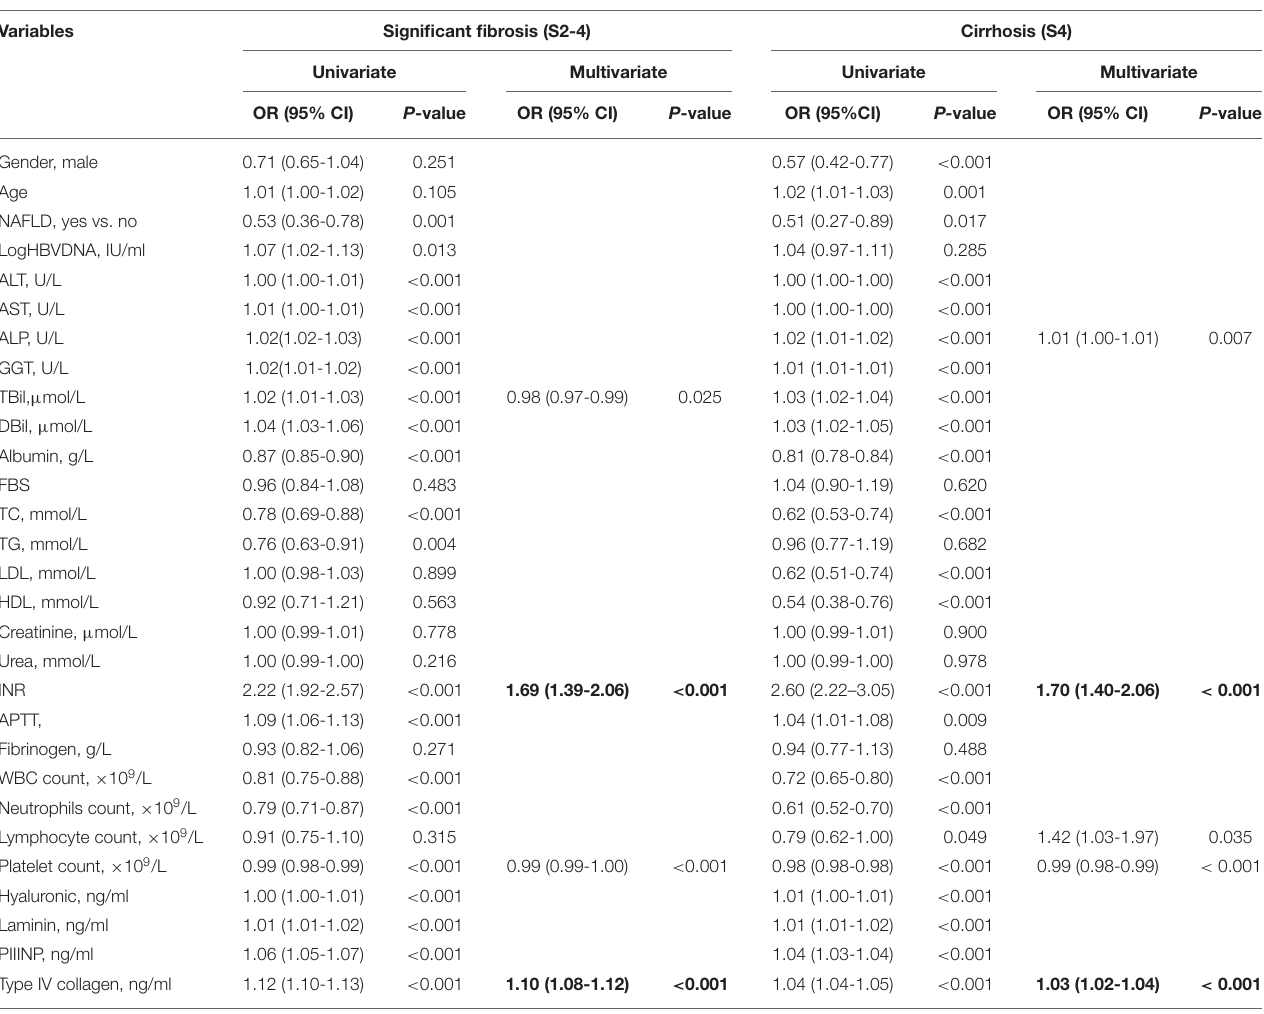
TABLE 2 | Variables associated with significant fibrosis and cirrhosis by logistic analysis in training